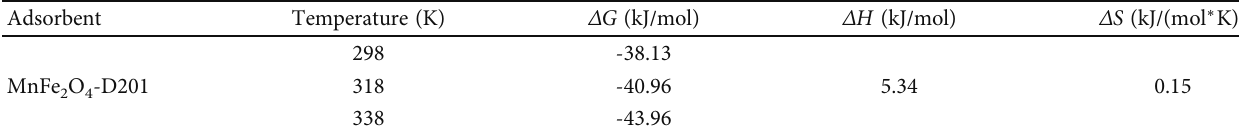
Table 3: Thermodynamic parameters for the adsorption.